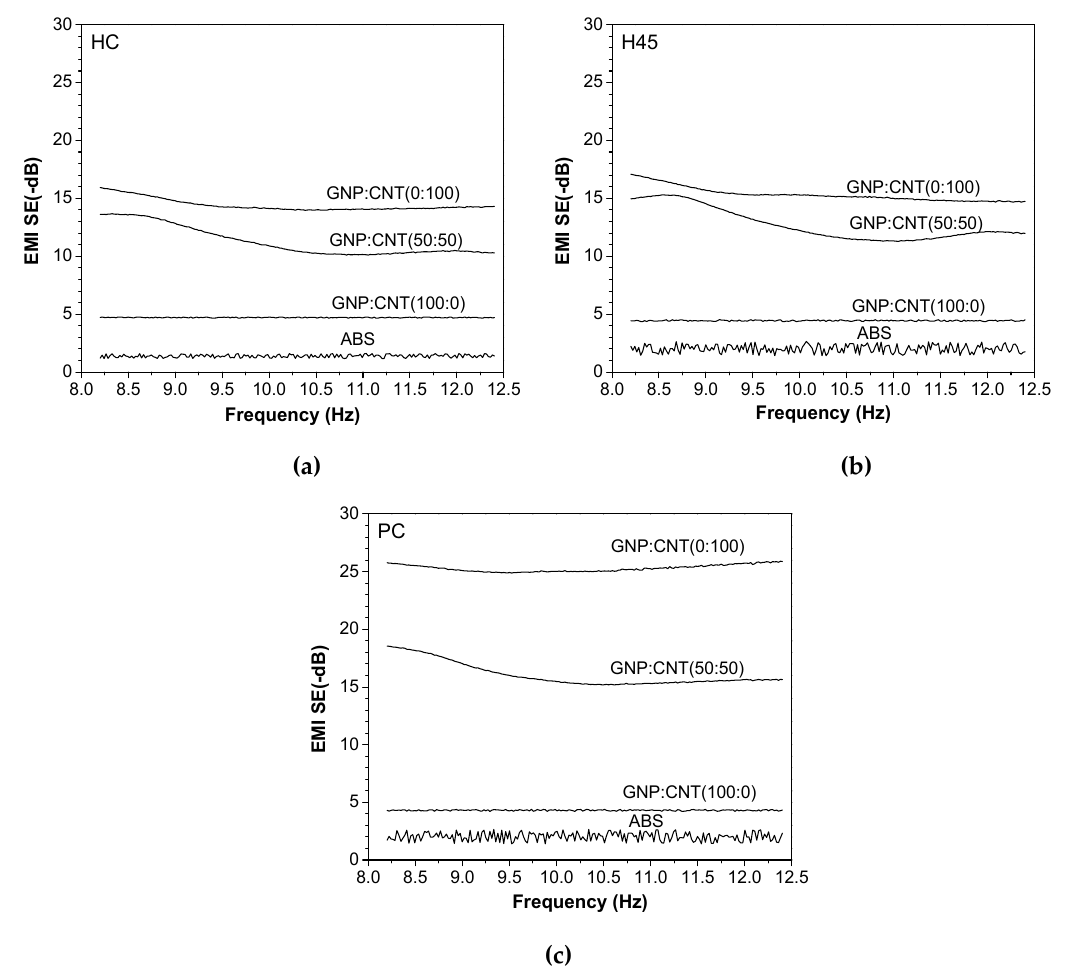
Figure 9. Representative curves of EMI SE of hybrid nanocomposite samples produced by FFF three-dimensional (3D) printing: ( a ) HC, ( b ) H45, and ( c ) PC.